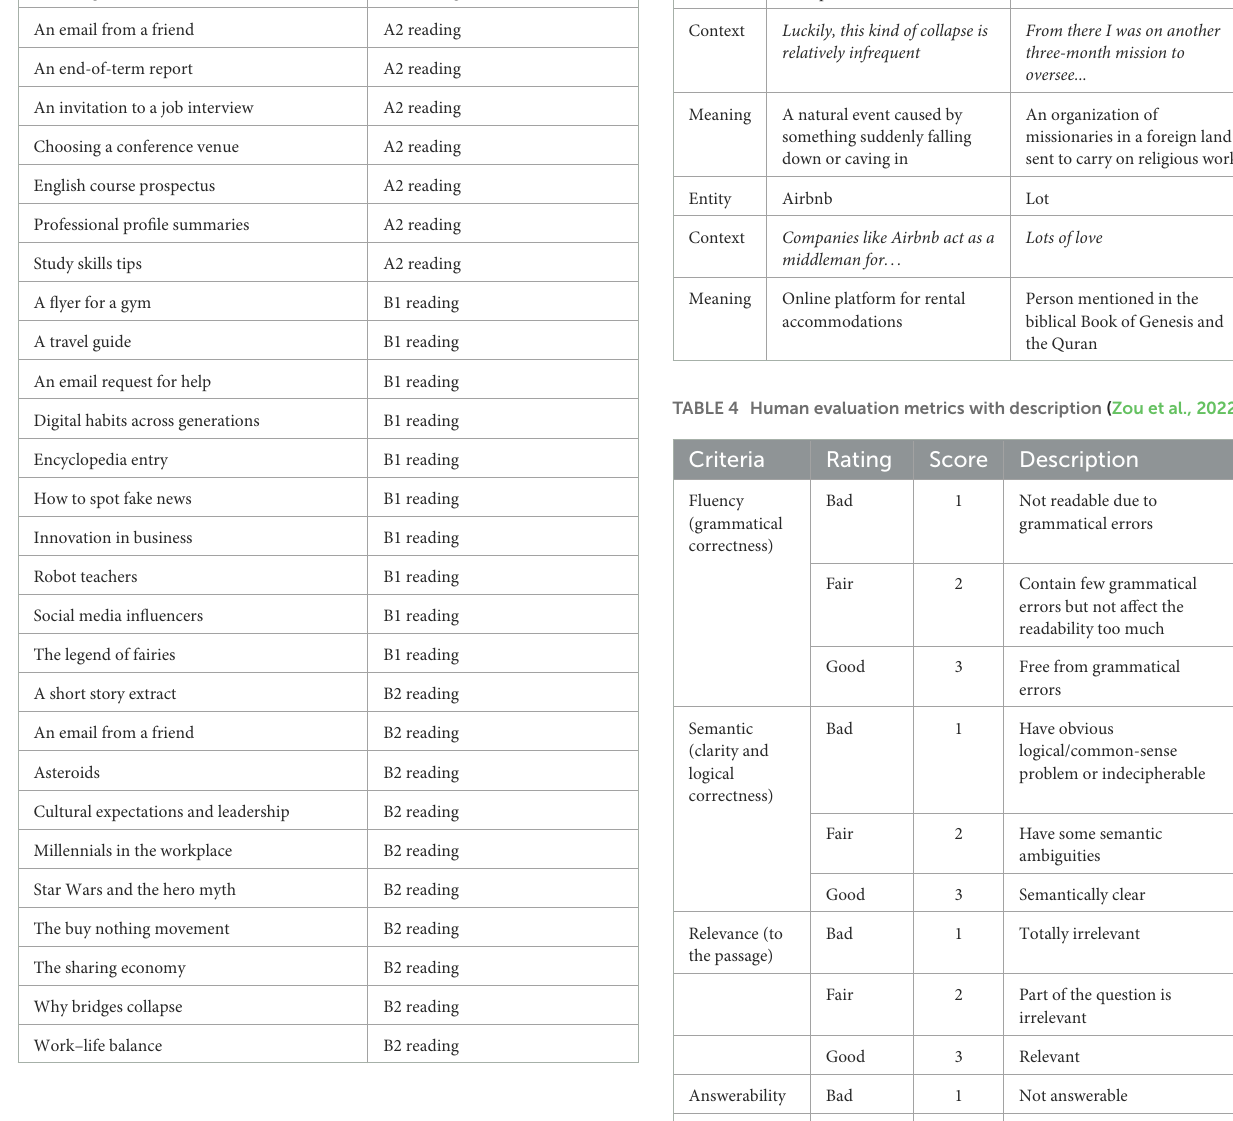
TABLE 2 Summary of the reading materials and the model results.